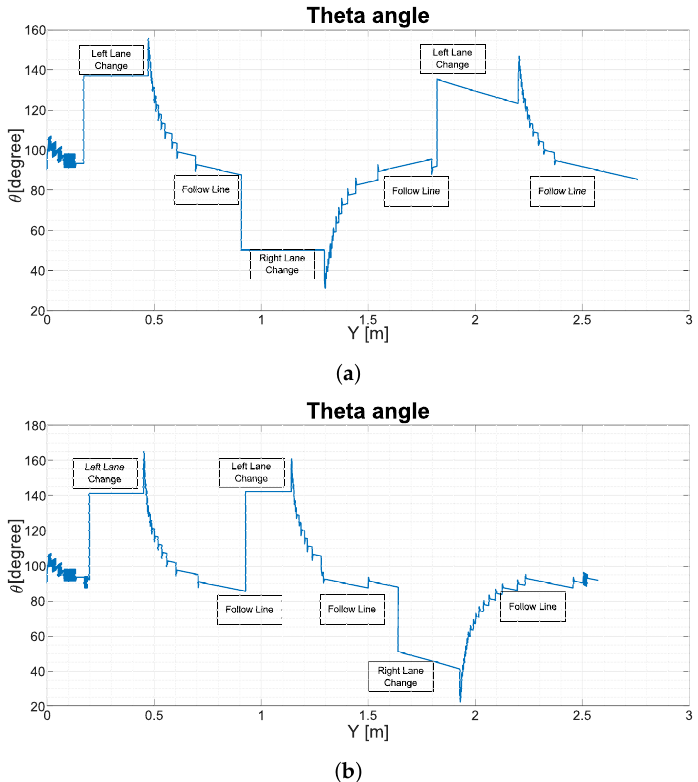
Figure 8. Theta angles (direction) of the WMR during the simulations. ( a ) θ angle in the first scenario. ( b ) θ angle in the second